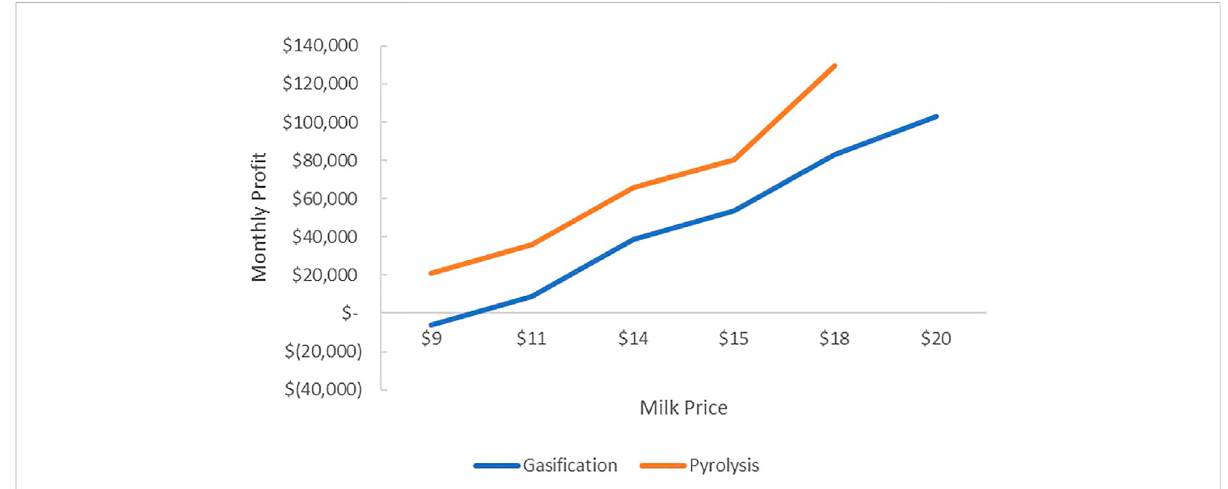
FIGURE 7 Monthly Income at varied milk price using Gasi fi cation and